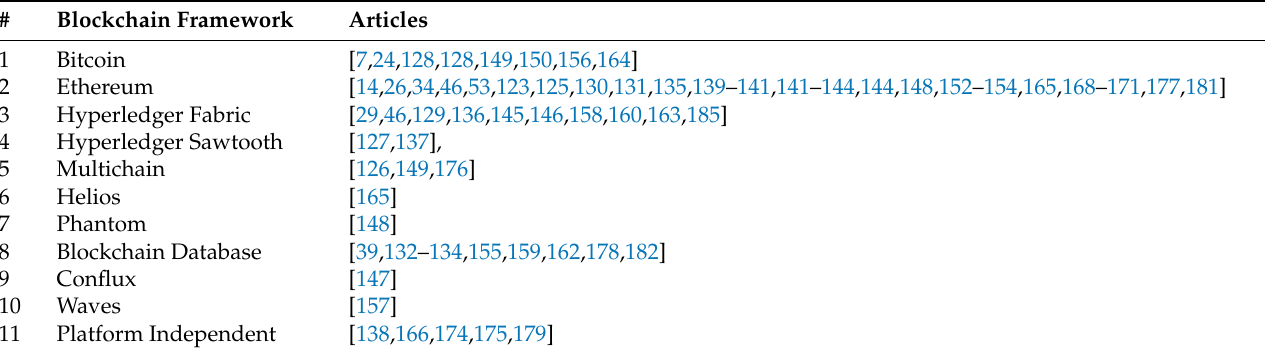
Table 9. Studies utilizing specific Blockchain